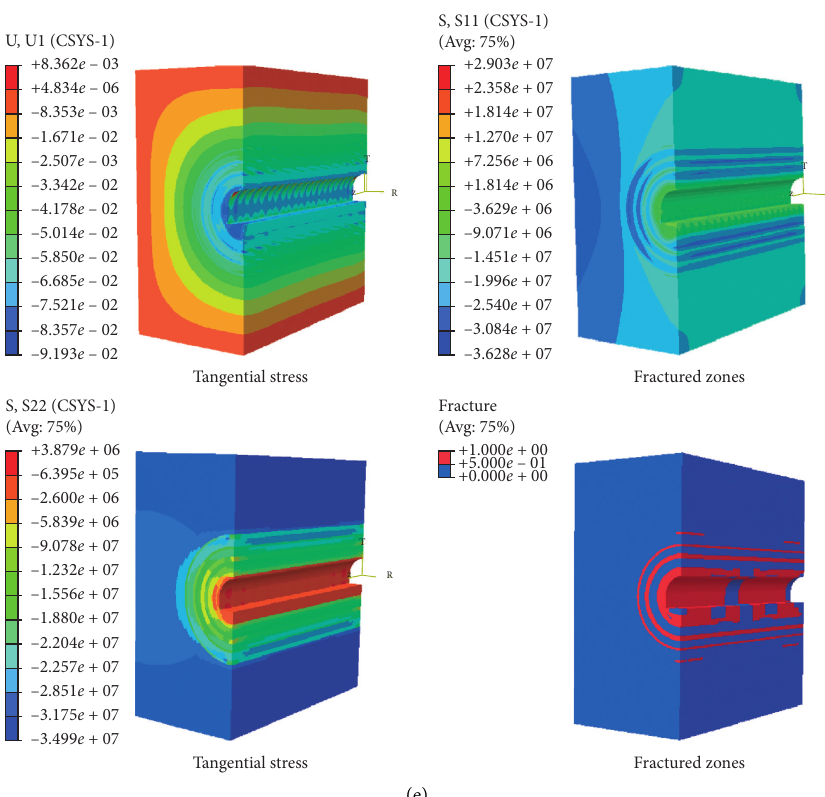
Figure 14: Fractured zone nephogram of surrounding rock. (a) t � 250 μ s . (b) t � 500 μ s . (c) t � 2500 μ s . (d) t � 6000 μ s . (e) Ultimate